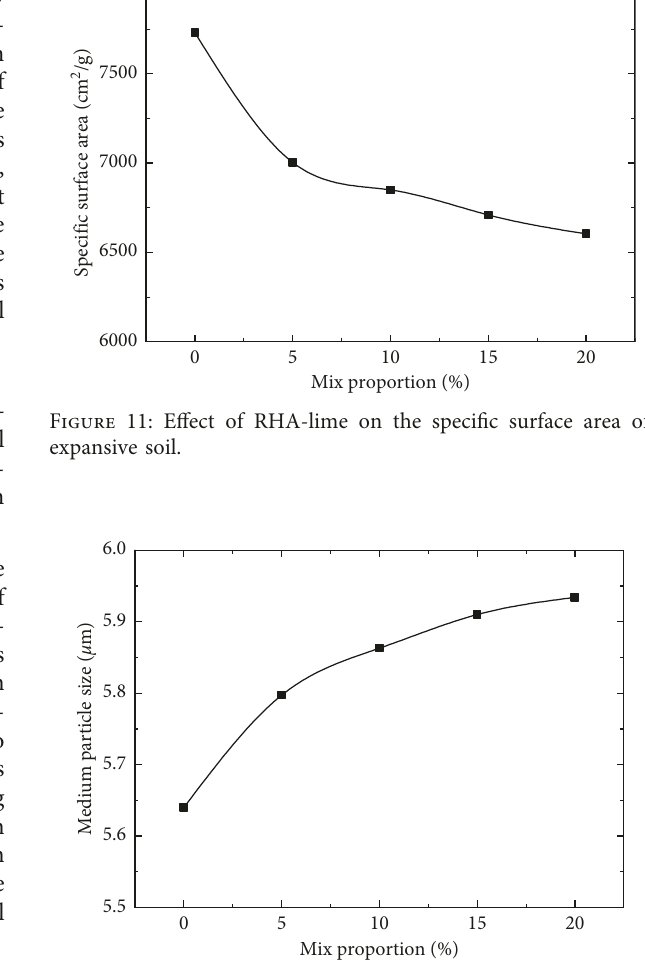
Figure 12: Effect of RHA-lime on the medium particle size of expansive